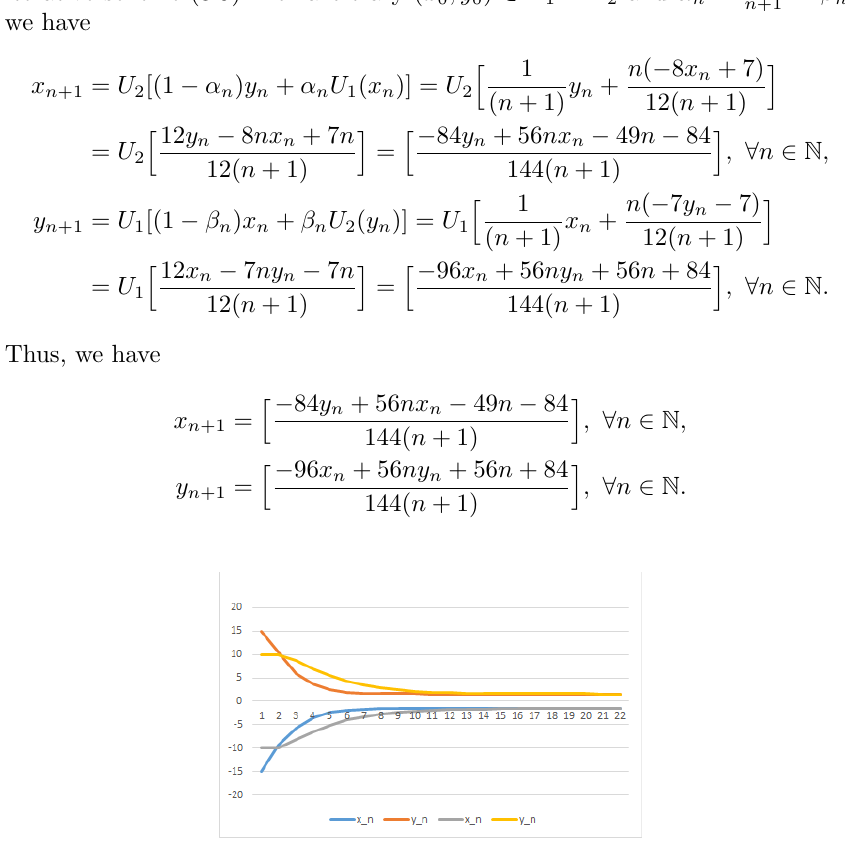
Figure 1. Convergence of parallel Mann iterative method (3.13) and parallel S -iterative method (3.14). The convergence of sequences { x n } and { y n } is plotted in Figures 1 and 2 using different initial values and from Table 1 and Table 2, we infer that the sequences { x n } and { y n } produced by the presented iterative methods converge to the altering points x = − 1 . 51136 and y = 1 .